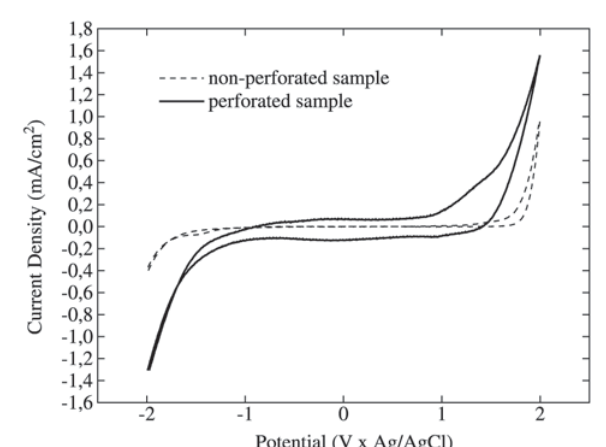
Figure 3. Cyclic voltametric behavior of the electrodes in 0,1 M KCl solution at v=100